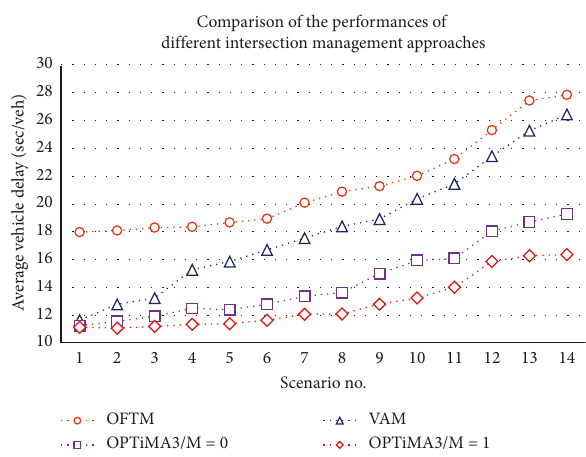
Figure 9: Comparison of the performances of different intersection management